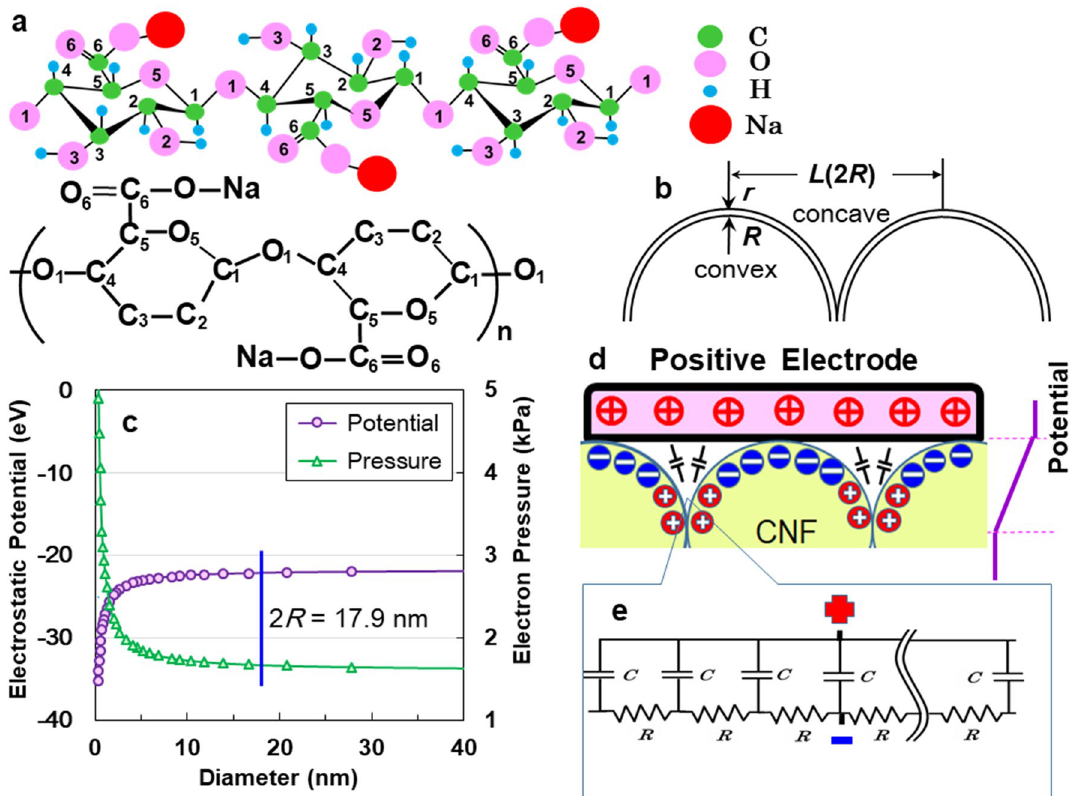
Figure 4. ( a ) Structure of sodium (1 → 4)-β-D-poly-glucuronate cell with green carbon, pink oxygen, light- blue hydrogen, and red sodium atoms. ( b ) Schematic diagram for calculations based on the Thomas–Fermi statistical method. ( c ) Convex dependences of the electrostatic potential and electron pressure with diameter. ( d ) Schematic representation of the microscopic electric energy storage used in this study. ( e ) The electric distributed constant circuit of the amorphous ACF